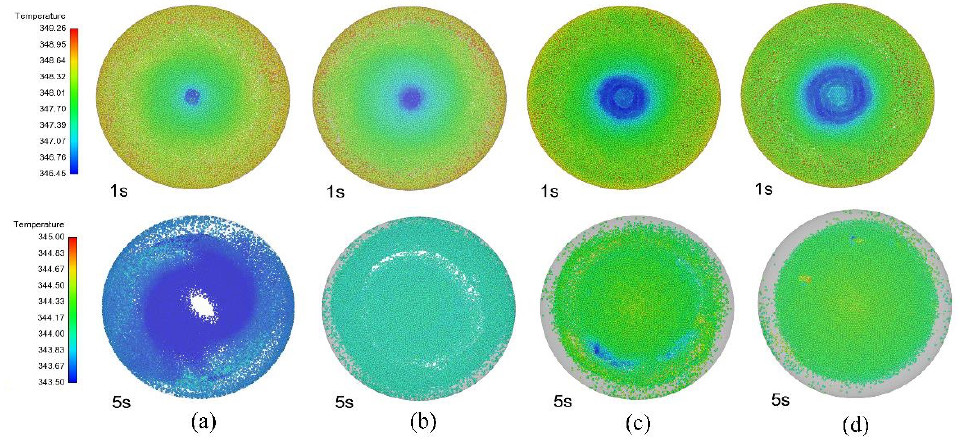
Figure 13. Schematic diagram of temperature and distribution of particles at the bottom of four tanks. The height of blades is ( a ) 30 mm, ( b ) 40 mm, ( c ) 50 mm, and ( d ) 60 mm.